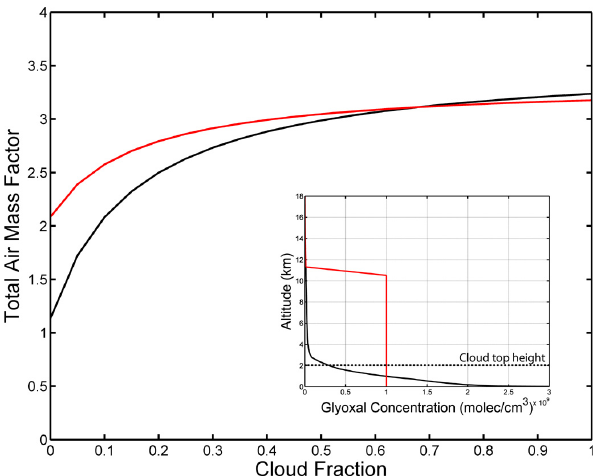
Fig. 8. Mean total errors associated to the glyoxal VCD retrieved from GOME-2 measurements in March 2007 (black) plotted as a function of the cloud fraction for (a) a continental and (b) an oceanic region. The contribution of the different types of errors is also illustrated: the contribution of the systematic errors in the DOAS fit (red); the contribution of the AMF error (blue) and the er- ror associated to the ghost column correction (green). The random errors are negligible due to the large number of